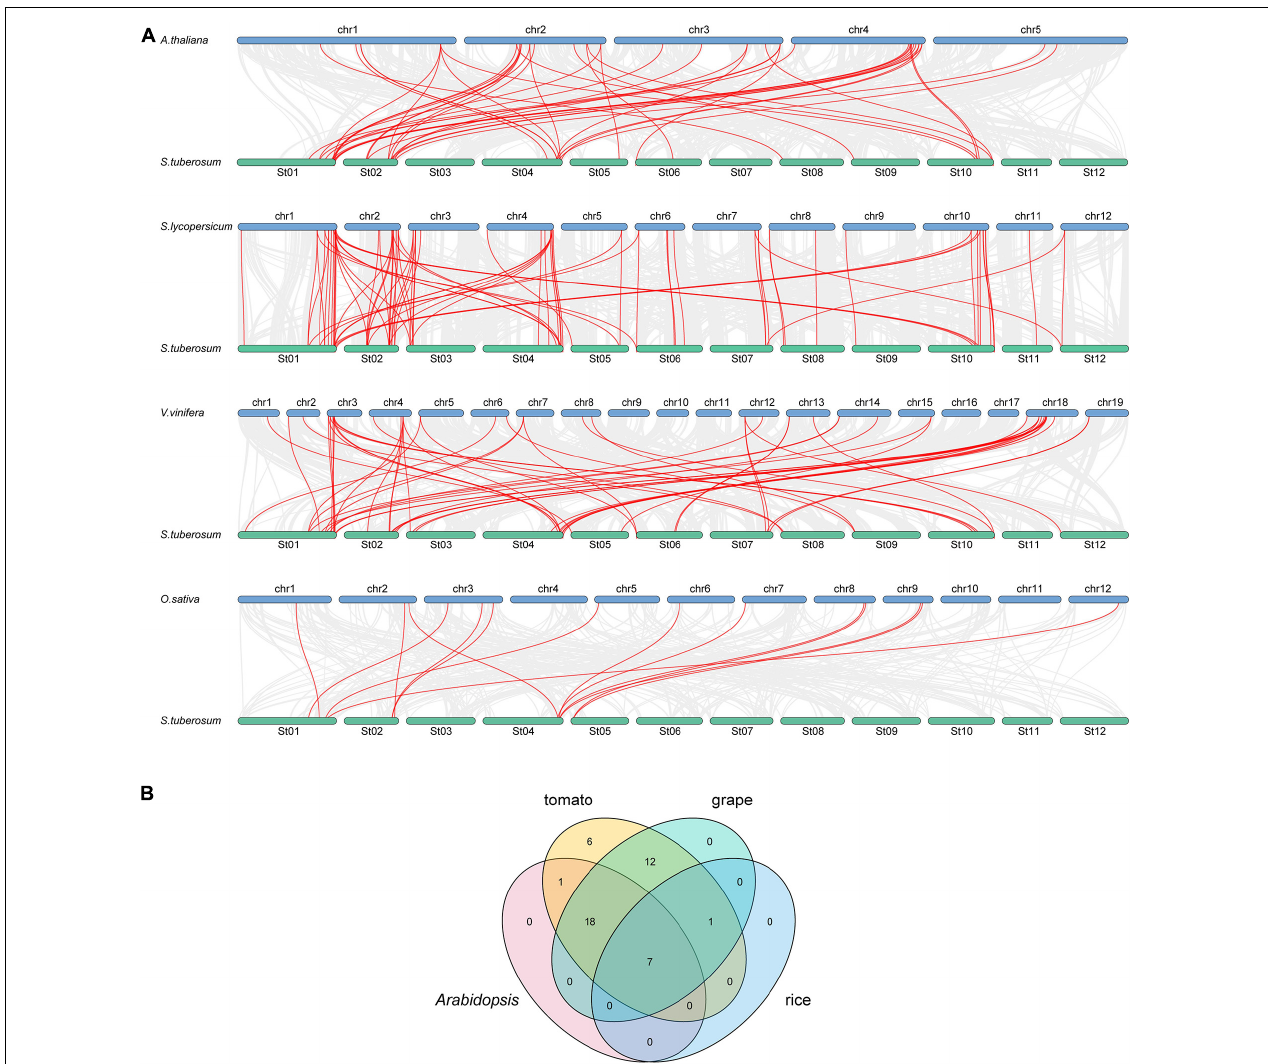
FIGURE 2 | Synteny analysis of bZIP genes between potato and four other representative plant species. (A) The gray line in the background represents the collinear blocks between potato and four other representative species, while the red line exhibit the syntenic bZIP gene pairs. (B) The numbers of bZIP genes that formed syntenic pairs between potato and all the other four selected species which visualized by the Venn